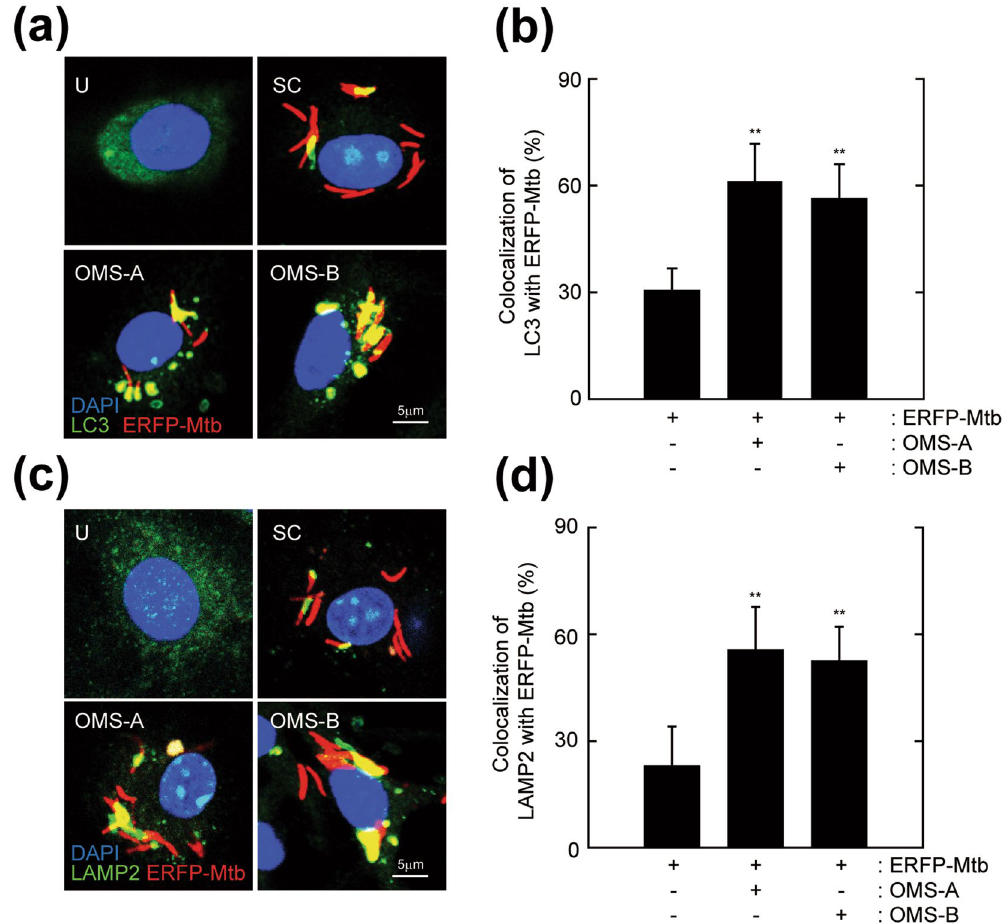
Figure 3. OMS-A and OMS-B activate phagosomal maturation against Mtb in macrophages. ( a – d ) BMDMs were infected with ERFP-Mtb (moi = 10) for 4 h and then treated with OMS-A (10 μ M) or OMS-B (10 μ M) for 24 h. ( a ) Mtb-ERFP (red), Alexa 488-conjugated-LC3 (green), and DAPI (blue) were detected by confocal analysis. Scale bar, 5 µ m. ( b ) Quantitative analysis of Mtb-ERFP and LC3 colocalization per cell. ( c ) Mtb-ERFP (red), Alexa 488-conjuated LAMP2 (green), and DAPI (blue) were detected by confocal microscopy. Scale bar, 5 µ m. ( d ) Quantitative analysis of Mtb and LAMP2 colocalization per cell. Representative confocal microscopic images from three independent samples are shown, with each experiment including at least 100 cells scored from 6 random fields ( a , c ). Data shown are from one representative of at least three independent experiments (means ± SD of triplicates [b, d] samples). ** p < 0.01, compared with ERFP-Mtb-infected control ( b , d ). U, uninfected/untreated; SC, solvent